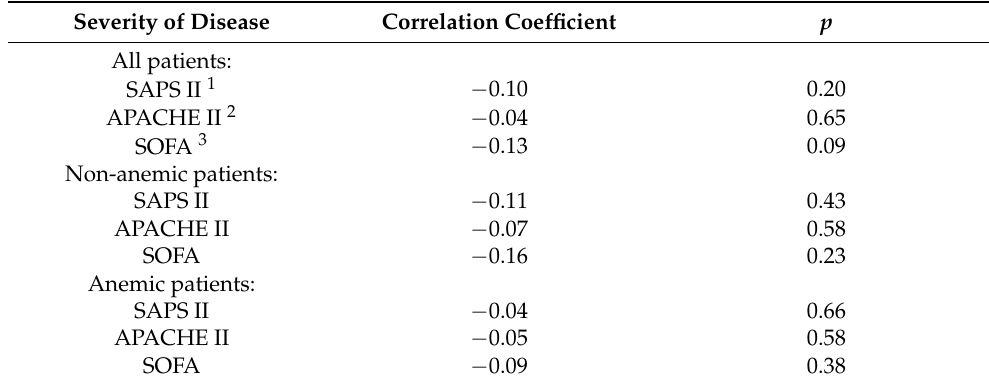
Table 3. Association between Hb changes during the first 7 days of ICU hospitalization and severity of disease in patients with and without anemia on admission to ICU.